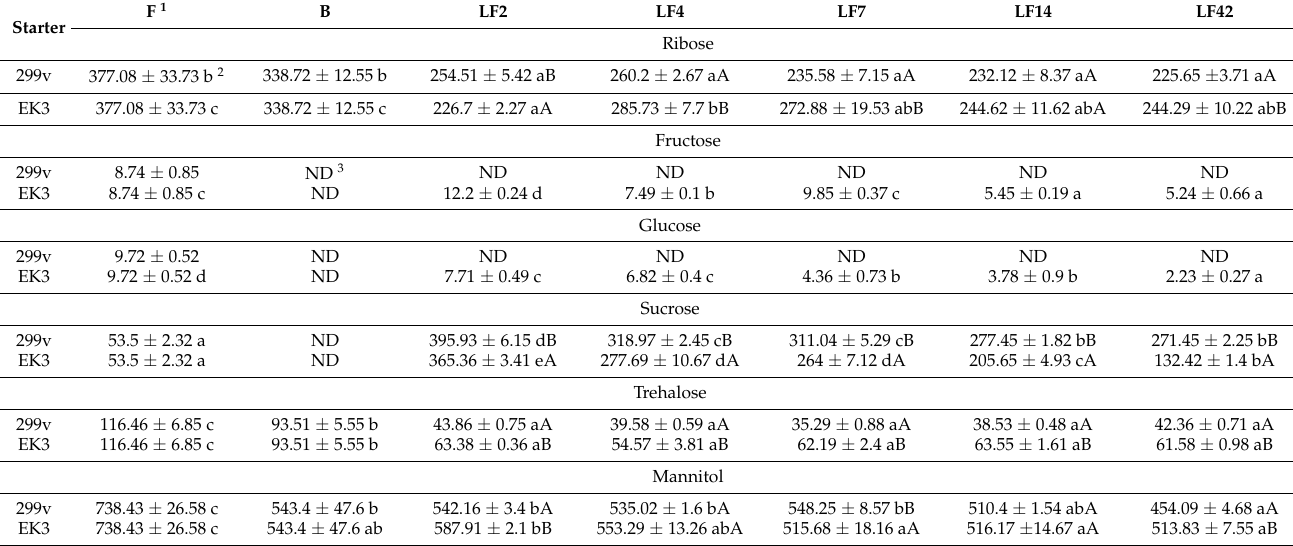
Table 3. Content of free sugars and mannitol in mushrooms (mg/100